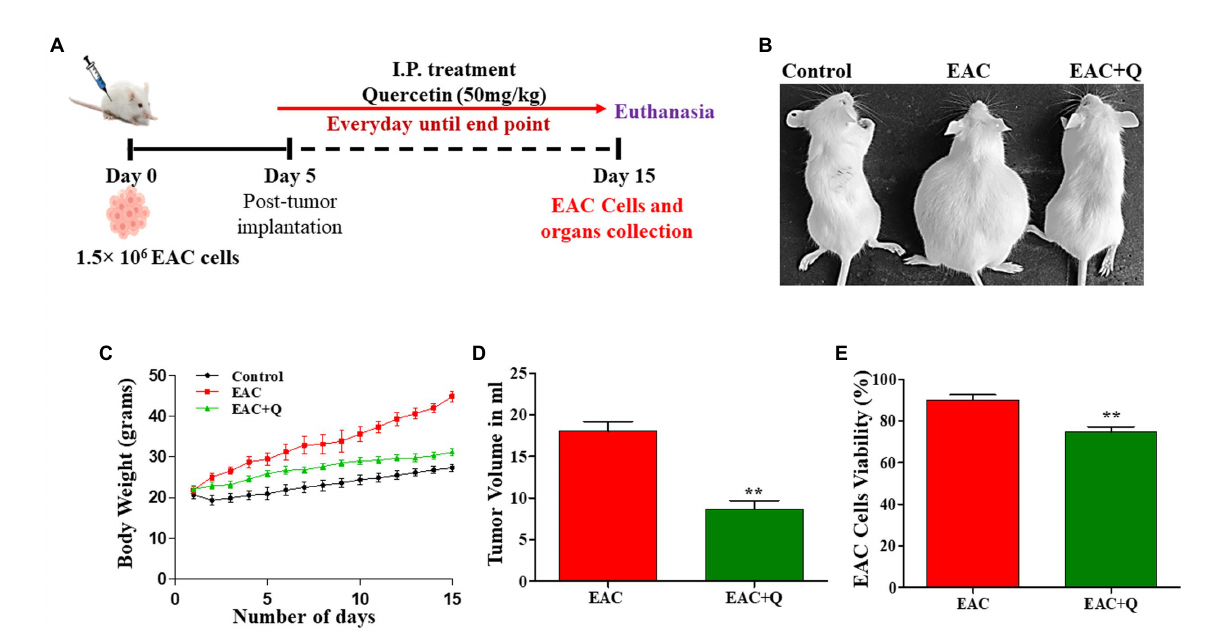
FIGURE 1 Quercetin has an anti-tumor effect against EAC cells. (A) Schematic treatment pattern of quercetin-EAC liquid tumor model. (B) Image representing the reduction of body weight in quercetin treated EAC mice compare to control EAC bearing mice. (C) Graph representing the decrease in the body weight of quercetin treated EAC animals compare to control EAC bearing animals ( n = 5/group). (D,E) Effect of quercetin on tumor volume and EAC cell viability (%) when compared to control EAC bearing animals ( n = 5/group). ** represents that p values less than